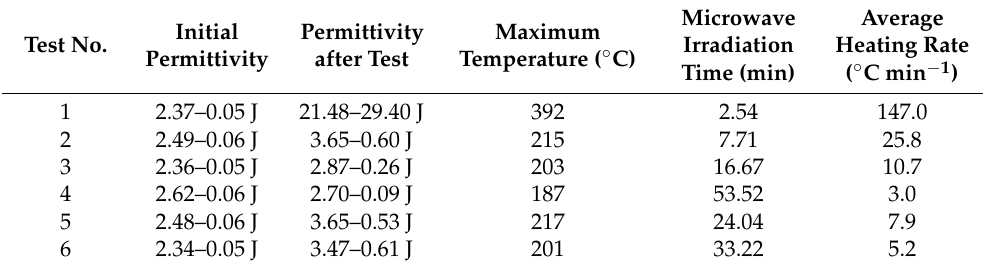
Table 5. Permittivity before and after test process, maximum temperature, irradiation time, and average heating rate for every test.